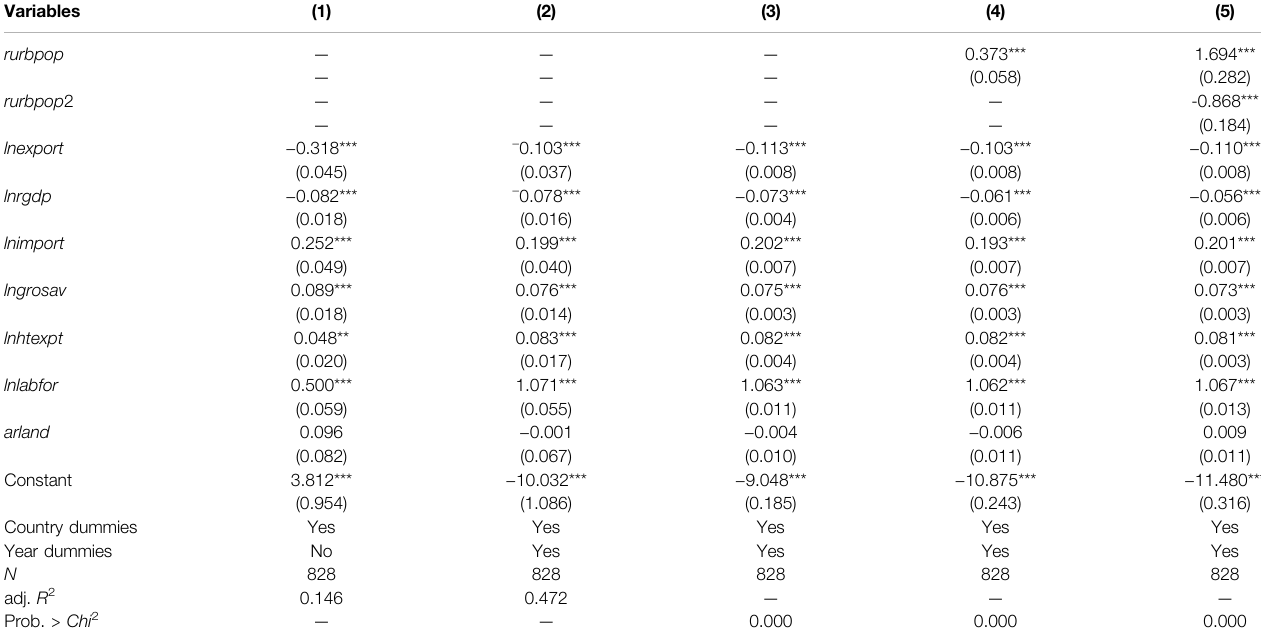
TABLE 2 | Results of baseline estimations.